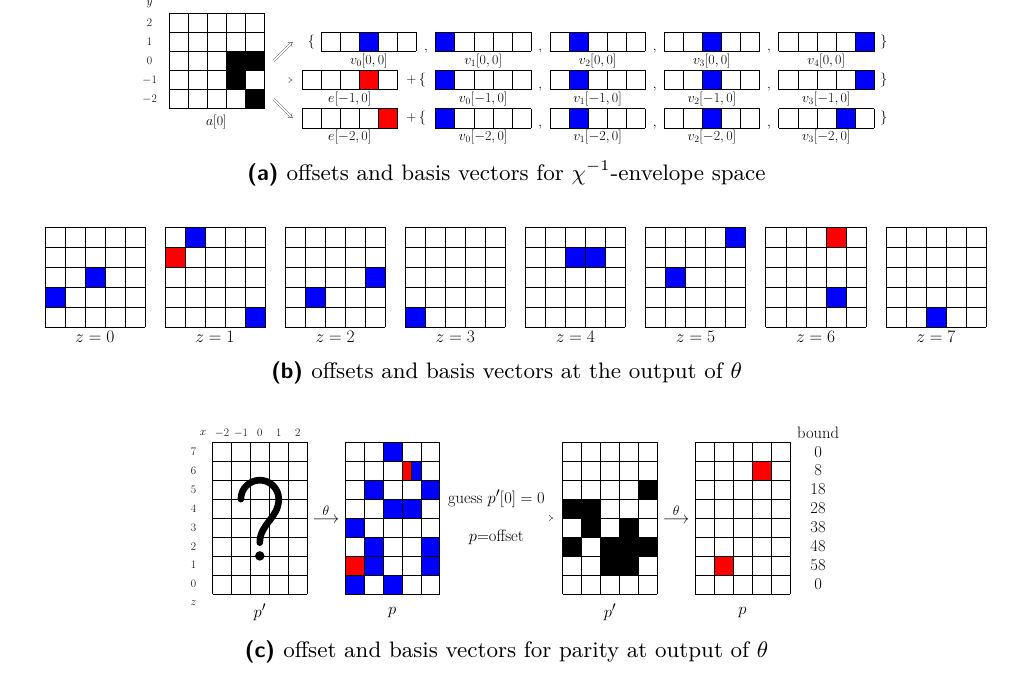
Figure 5: Example on backward extension. In (a) the active rows of a define offset and basis vectors for the χ − 1 -envelope space. In (b) offset and basis vectors are mapped through π − 1 · ρ − 1 . For the sake of compactness, offset and basis vectors are grouped by slices. This representation allows immediately noticing that there are no basis vectors in slice z = 1 with an active bit in column x = − 2 to complement the offset bit in that column. It follows that a cannot be backward extended in the kernel. In (c) on the left, we derive offset and basis vectors for the space of parity patterns p after θ . In (c) on the right, parity patterns p 0 and p are incrementally generated and the bound is incrementally computed in the case guess on p 0 [0] is 0 and p is the offset. The computed value of p 0 [1] will imply value 11010 for p 0 [0], which is inconsistent with the